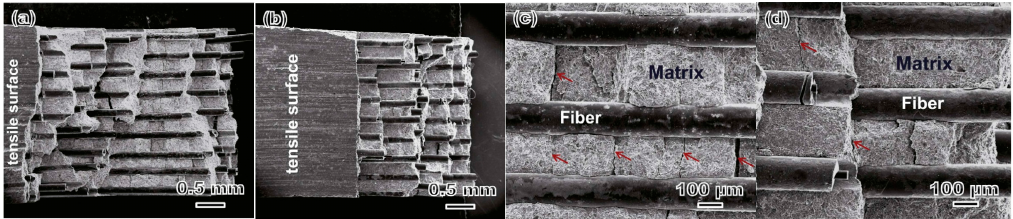
Figure 4. FE-SEM images of the fracture surfaces of ( a , c ) composites prepared at 1250 °C and ( b , d ) composites prepared at 1300 °C; the images show a step-like fracture model (a,b) and multiple transversal cracks in the matrix (c,d) [32].